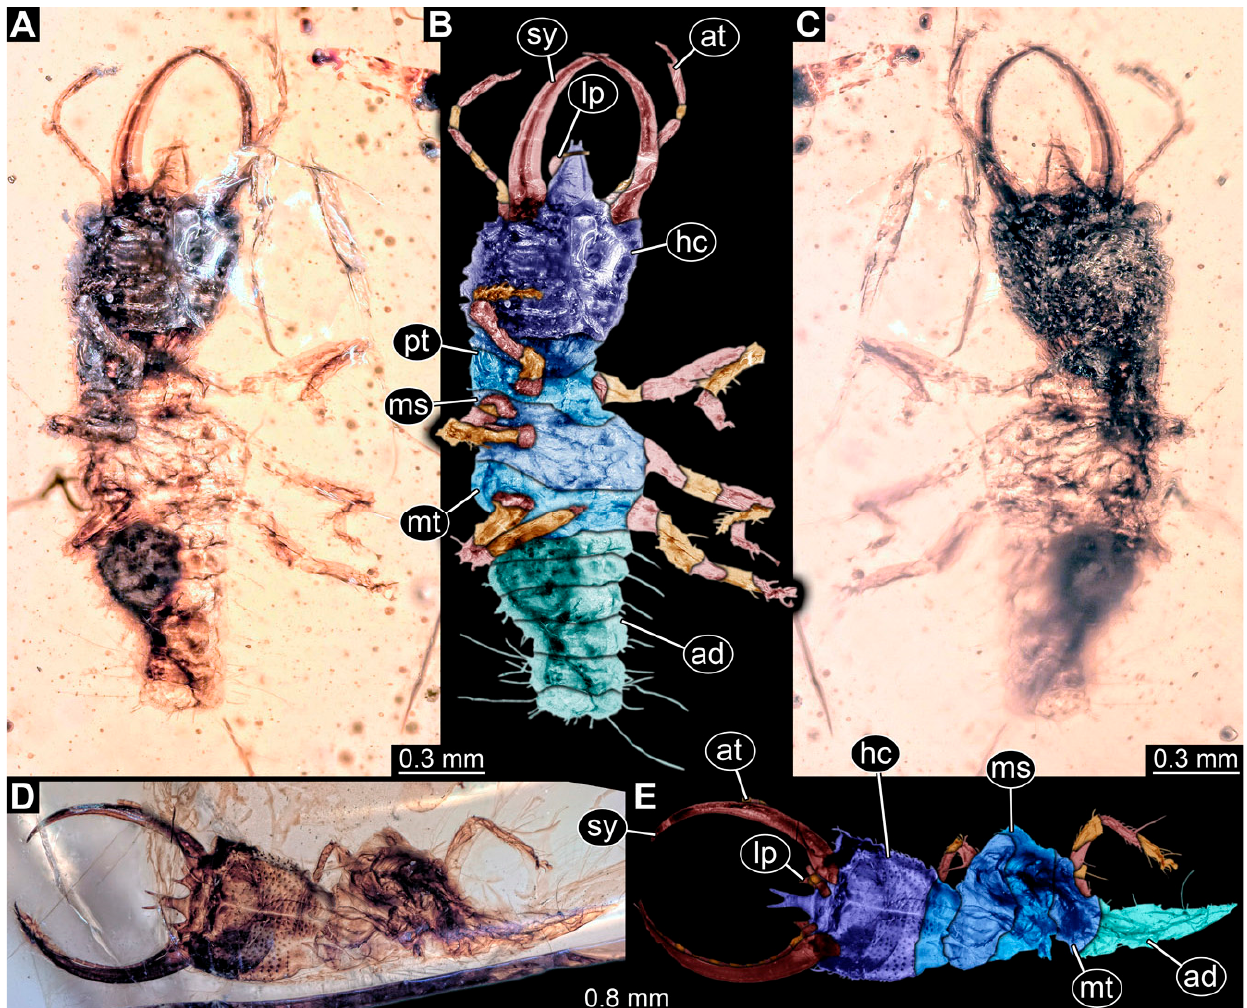
Figure 7. Specimens in Myanmar amber. ( A – C ) Specimen 63 (PED 0535). ( A ) Ventral view. ( B ) Ventral view, colour-marked. ( C ) Dorsal view. ( D , E ) Specimen 60 (PED 0430). ( D ) Dorsal view. ( E ) Dorsal view, colour-marked. Abbreviations: ad = abdomen; at = antenna; hc = head capsule; lp = labial palp; ms = mesothorax; mt = metathorax; pt = prothorax; sy = stylet. (9) Specimen 61 (PED 0440) is preserved in Cretaceous Myanmar amber. It is accessible from the dorsal side (Figure 8A,B), but strongly verlumt from the ventral side. The labrum is triangular to pentagonal in the dorsal view. The antennae bear prominent setae at the distal ends. Trumpet-shaped empodia at the end of the locomotory appendages are visible. The specimen has an approximate length of 1.2 mm.